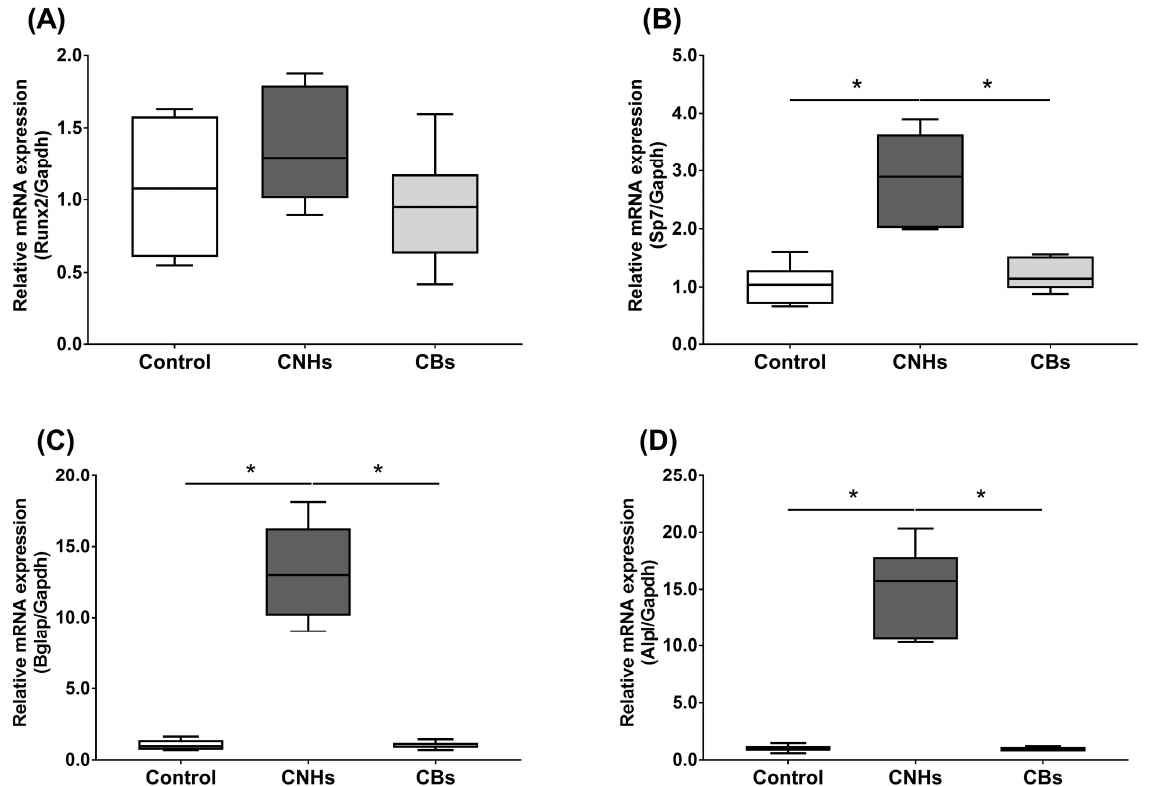
Figure 6. Effects of CNMs on gene expression in OBs. The OBs were exposed to CHNs and CBs. The relative amounts of Runx2 ( A ), Sp7 ( B ), Bglap ( C ), and Alpl ( D ). mRNAs were analyzed by quantitative real-time PCR (n = 6 cultures each). The horizontal line in each box indicates the median, the box shows the interquartile range (IQR), and the whiskers are 1.5 × IQR. Statistical significance was evaluated using the Steel–Dwass test. * p < 0.05.